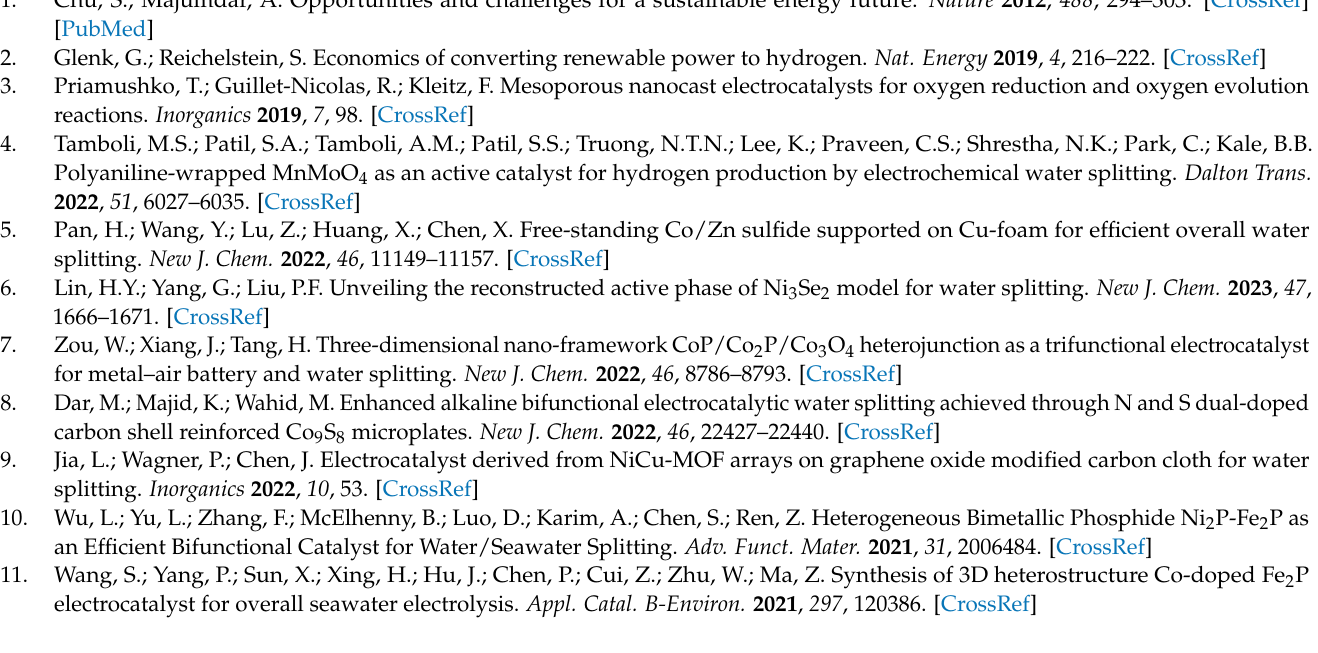
Figure S4: (a,b) CV curves of NF@NiB and Bare NF for HER in 1.0 M KOH + 0.5 M NaCl with a scan rate of 50 mV s-1; (d, e) CV curves of NF@NiB and Bare NF for OER in 1.0 M KOH + 0.5 M NaCl with a scan rate of 50 mV s-1; (c,f) The calculated TOFs curves for HER and OER; Figure S5: XRD spectra of NF@NiBx after HER and OER stability measurements; Figure S6: SEM images of NF@NiB after HER (a) and OER(b) stability tests; Figure S7: LSV curves of NF@NiBx and Bare NF electrodes for OER in 1 M KOH solution; Figure S8: LSV curves of NF@NiBx and Bare NF electrodes for OWS in 1 M KOH solution; Table S1: Comparison of overall water splitting performance of NF@NiB